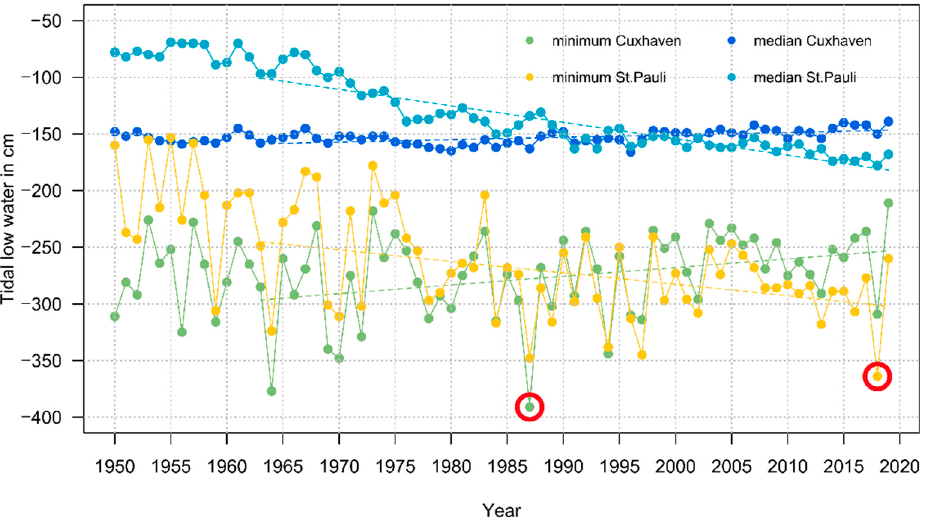
Figure 2. Minimum and median of tidal low water (LW) observations for each year between 1950 and 2019 at Cuxhaven (mouth of the estuary) and St. Pauli (Hamburg harbour) relative to NHN. The lowest LW ever measured at Cuxhaven was found in 1987, for St. Pauli it was in 2018. The two corresponding values in Figure 2 are marked by red circles. The latter is